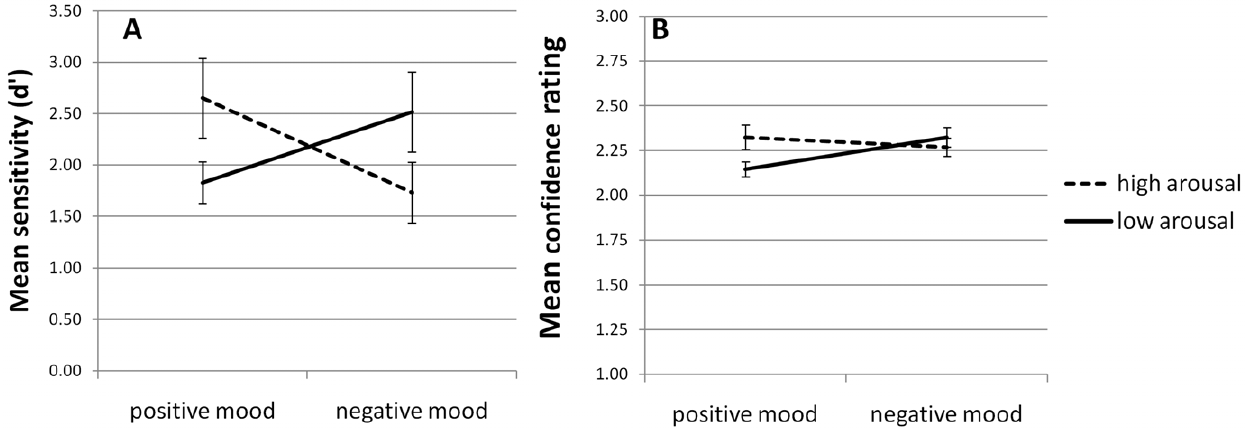
Figure 3. Sensitivity to old/new differences and confidence ratings in the four mood/arousal conditions. (A) The greatest sensitivity (d 9 ) was observed during the positive mood/high arousal and negative mood/low arousal conditions. (B) A similar pattern was observed in ratings of